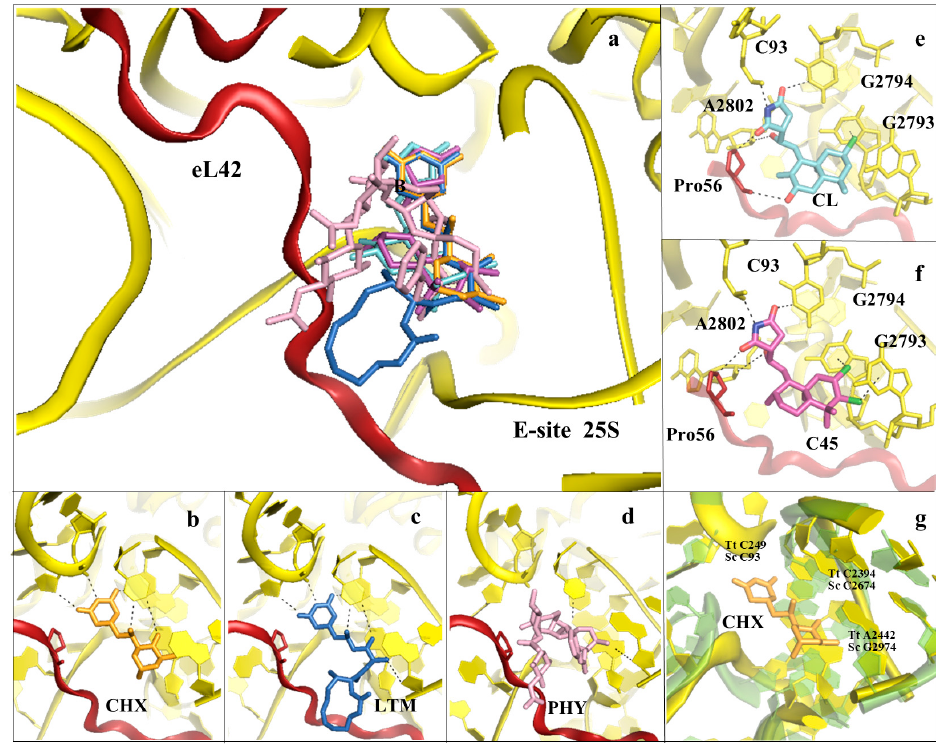
Figure 5. Inhibitors binding to the E-site of the LSU impair the translocation process. ( a ) Overview of the inhibitors targeting specifically the eukaryotic E-site. Cycloheximide (CHX) (PDB: 4U43) in orange, lactimidomycin (LTM) in blue (PDB: 4U4R), phyllantoside (PHY) in pink (PDB: 4U4Z), chlorolissoclimide (CL) in light cyan (PDB: 5TBW) and the synthetic analogue C45 in magenta (PDB: 6HHQ); ( b ) zoom-in and details of interaction for CHX within the E-site binding pocket; ( c ) zoom-in and details of interaction for LTM within the E-site binding pocket; ( d ) zoom-in and details of interaction for PHY within the E-site binding pocket. PHY, in contrast to CHX and LTM, is reported to interact directly with the eukaryotic-specific ribosomal protein eL42. eL42 is coloured in red for clarity; ( e ) zoom-in of CL interaction network within the E-site, with details of the hydrogen bonding and the peculiar halogen– π interaction that lissoclimides establish with rRNA residues. Additionally, CL interacts with the backbone of eL42; ( f ) same view for C45, with highlighted the second halogen– π interaction that the drug establishes with the rRNA. This additional bond might compensate for the lack of the hydrogen bond with eL42, as it occurs with CL. In both images, the type of bonding established between the drug and the ribosome is marked; ( g ) structural superimposition of the S. cerevisiae LSU (coloured in yellow) with the LSU of T. thermophilus (coloured in light green) (PDB: 4V5D) (rmsd 4.5 Å). Numbers of residues for the two organisms are shown (Sc: S. cerevisiae , Tt: T. thermophilus